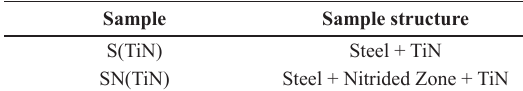
Table 2. Sample series and respective sample